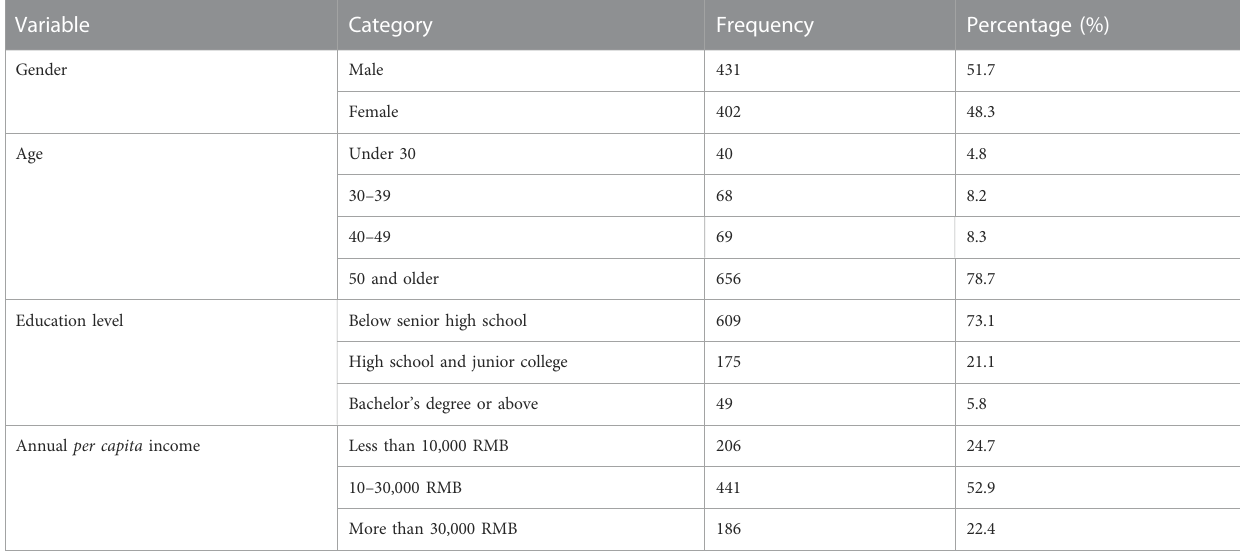
TABLE 1 Demographic characteristics of the